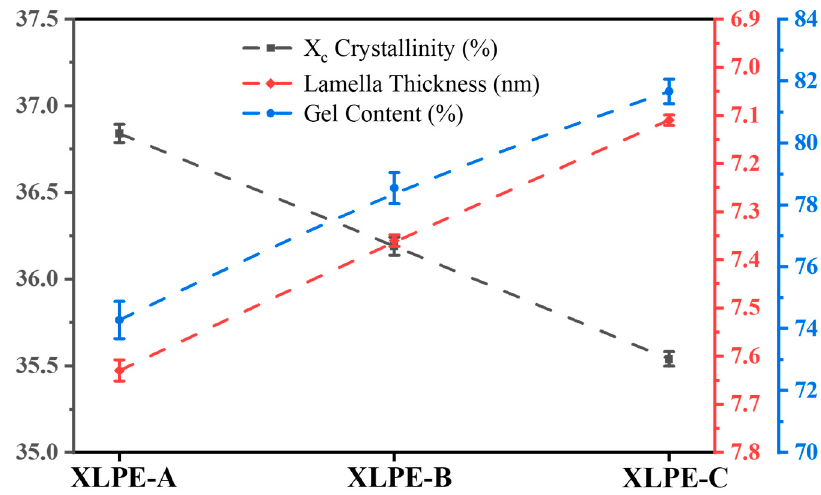
Figure 2. Comparative analysis of crystallinity, lamella thickness and gel content of XLPE prepared with DCP content of 1.4% (XLPE-A), 1.7% (XLPE-B) and 2% (XLPE-C).